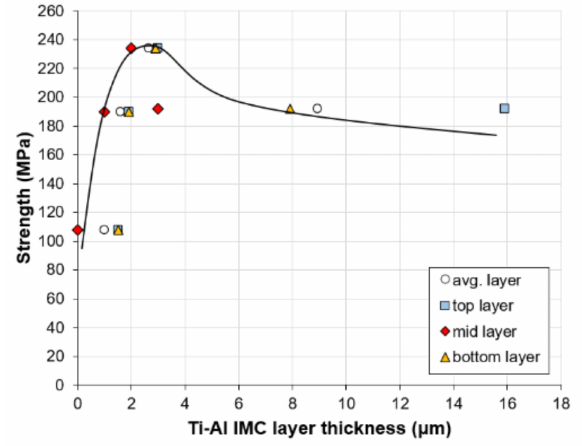
Figure 27. Effect of Ti–Al IMC layer thickness on strength based on [177].